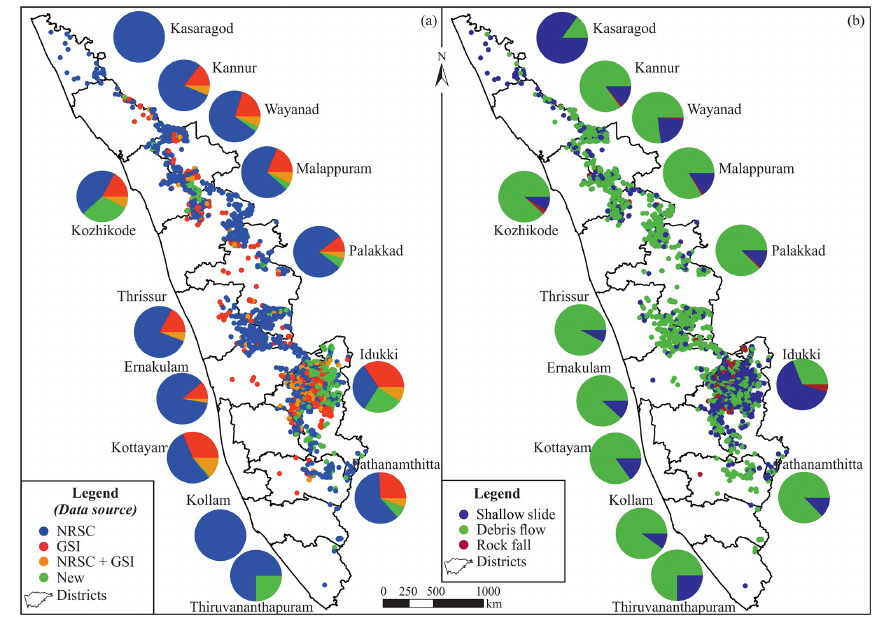
Figure 15. Map of the final landslide inventory dataset. (a) distribution according to the source of the data and (b) distribution of different landslide